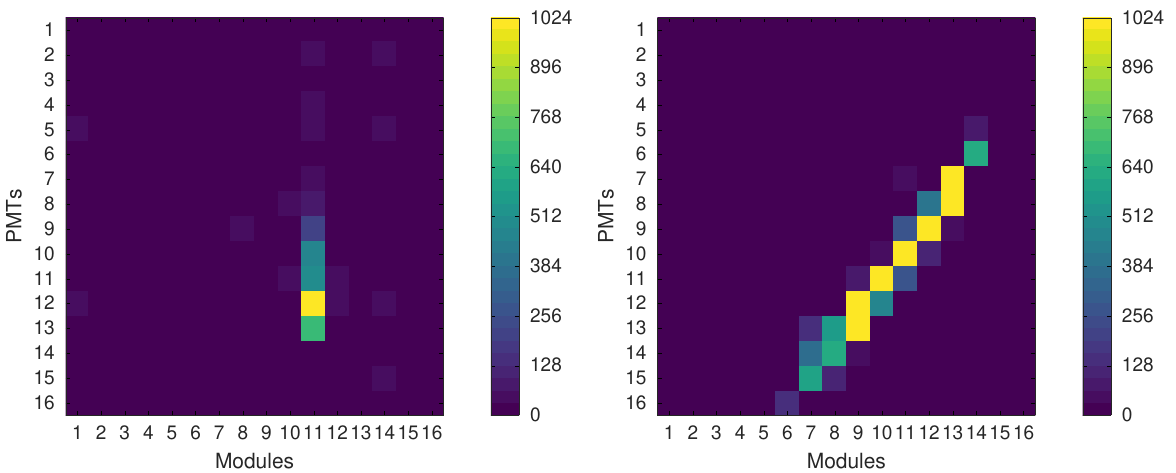
Figure 3. Examples of “snapshots” of the focal surface at the moment of the (first) maximum of TLFs with clear linear tracks. Here and in what follows, colors in images such as these denote the value of ADC counts as shown in the color bars.